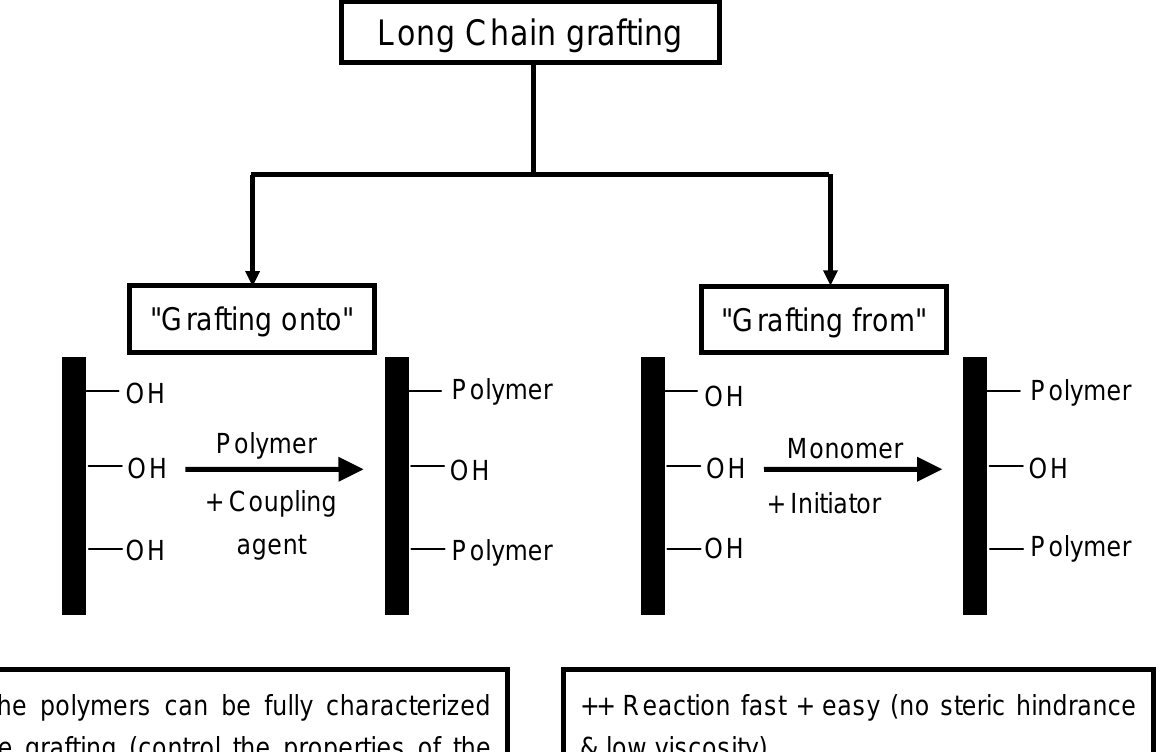
Figure 3. Schematic representation of the "grafting onto" and "grafting from" approaches. Long Chain grafting